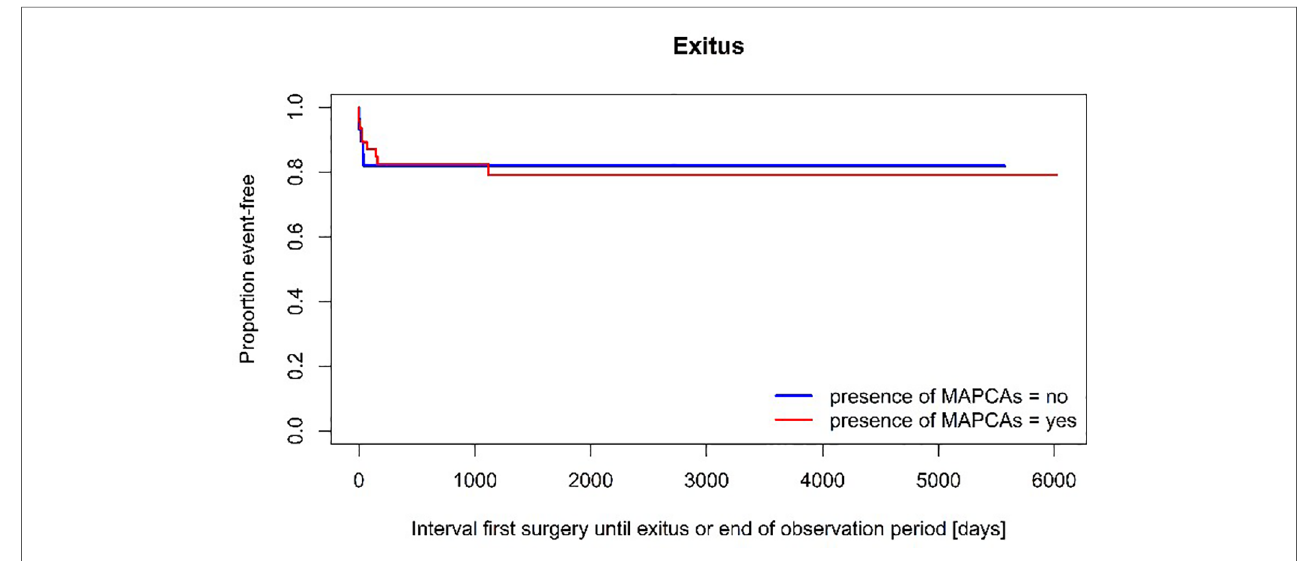
FIGURE 4 Survival — subgroup comparison (log-rank test: p =0,881).